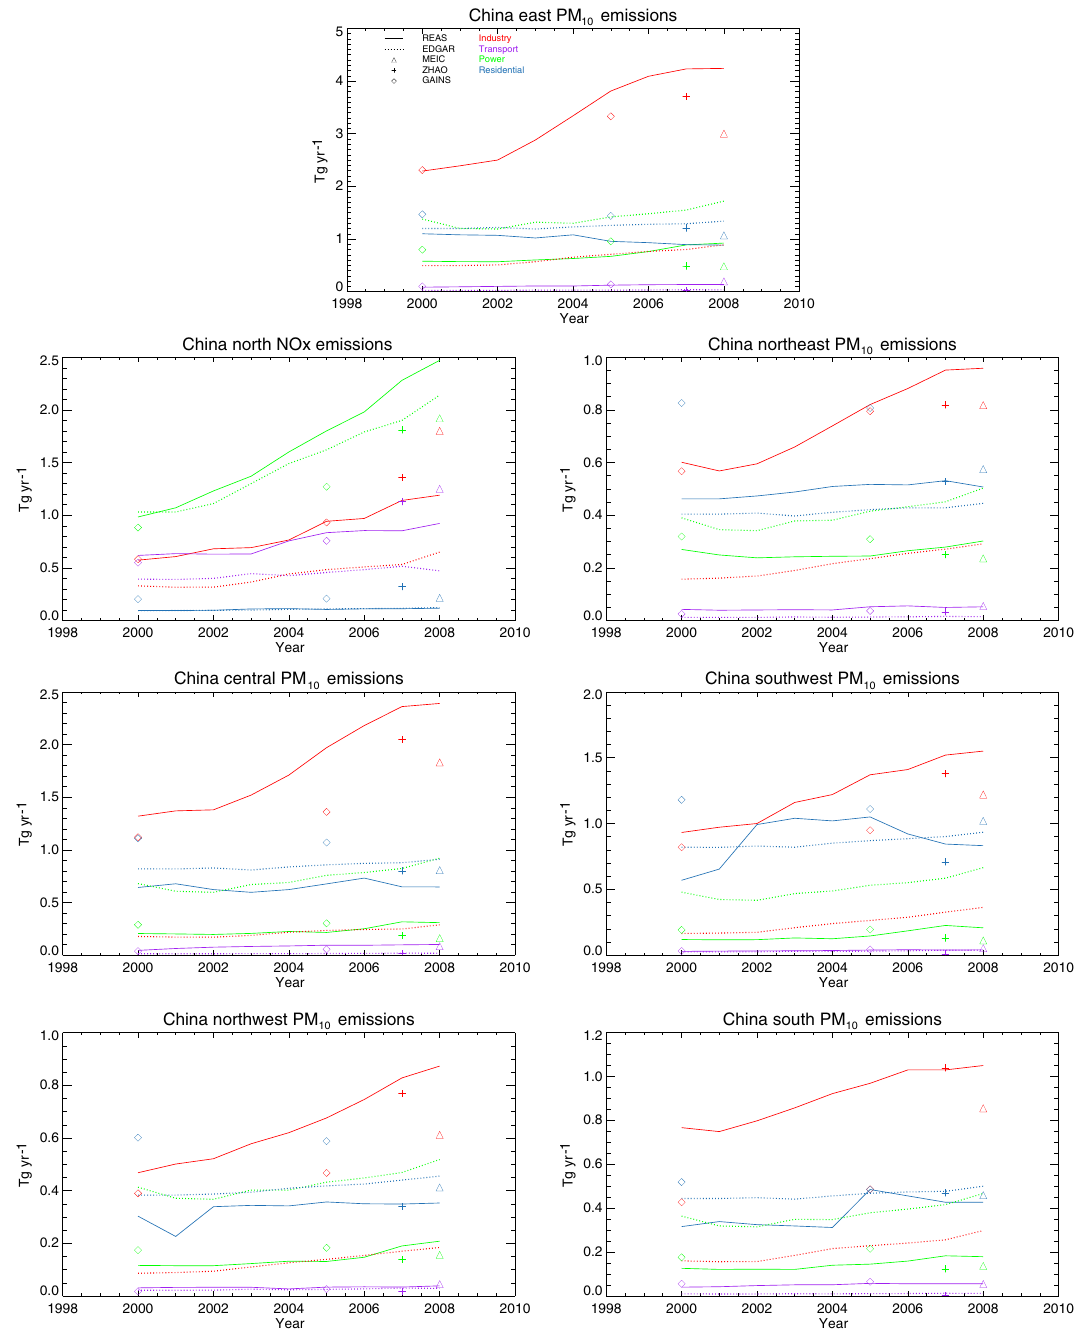
Figure 9. Regional total emissions for PM 10 for four different source sectors (industry, transport, power, and residential) estimated by REAS, EDGAR, MEIC, ZHAO, and GAINS between 2000 and